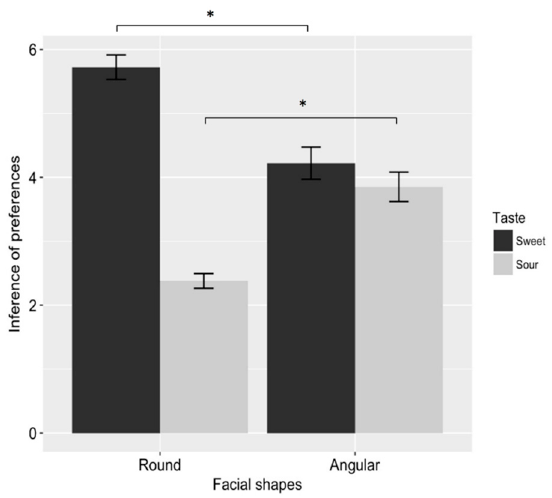
Figure 2. Results of Study 1. The round-faced person was perceived as more strongly preferring sweet (vs. sour) foods, while the angular-faced (vs. round-face) person was perceived as more strongly preferring sour (vs. sweet) foods. Error bars represent standard error. Asterisks denote significant difference ( p < 0.05 *).